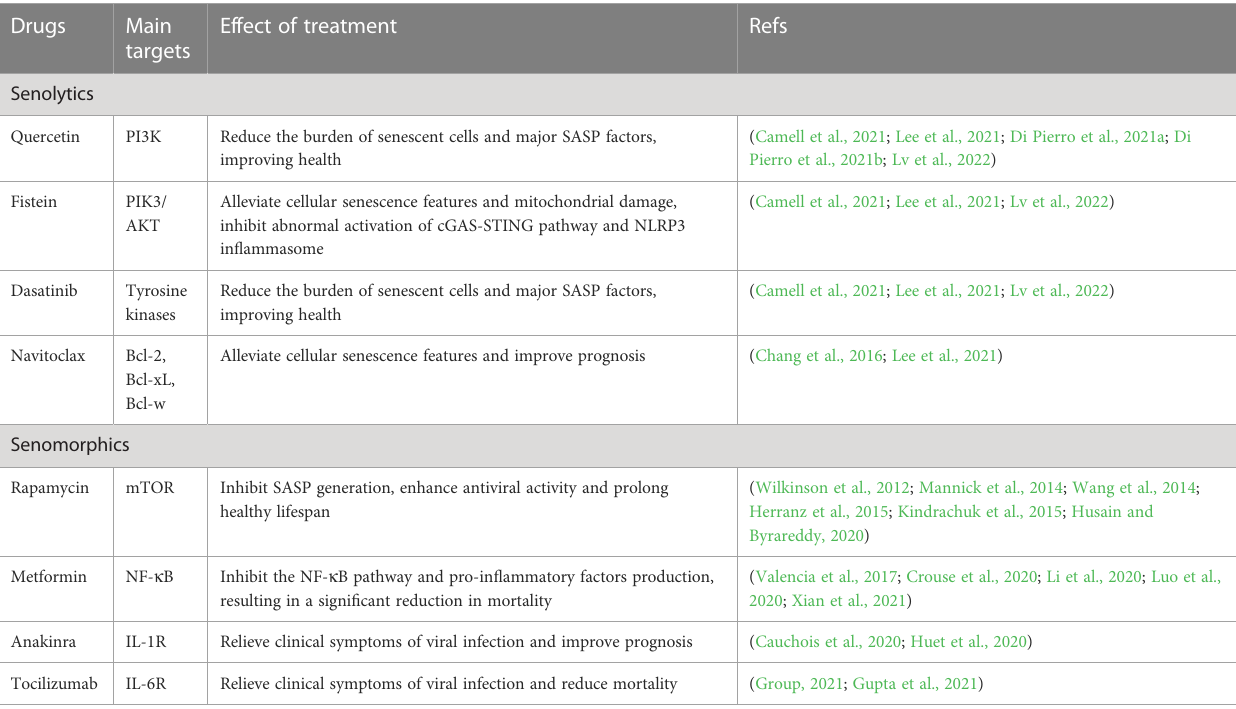
TABLE 2 Senescence-targeted therapeutics of viral infectious